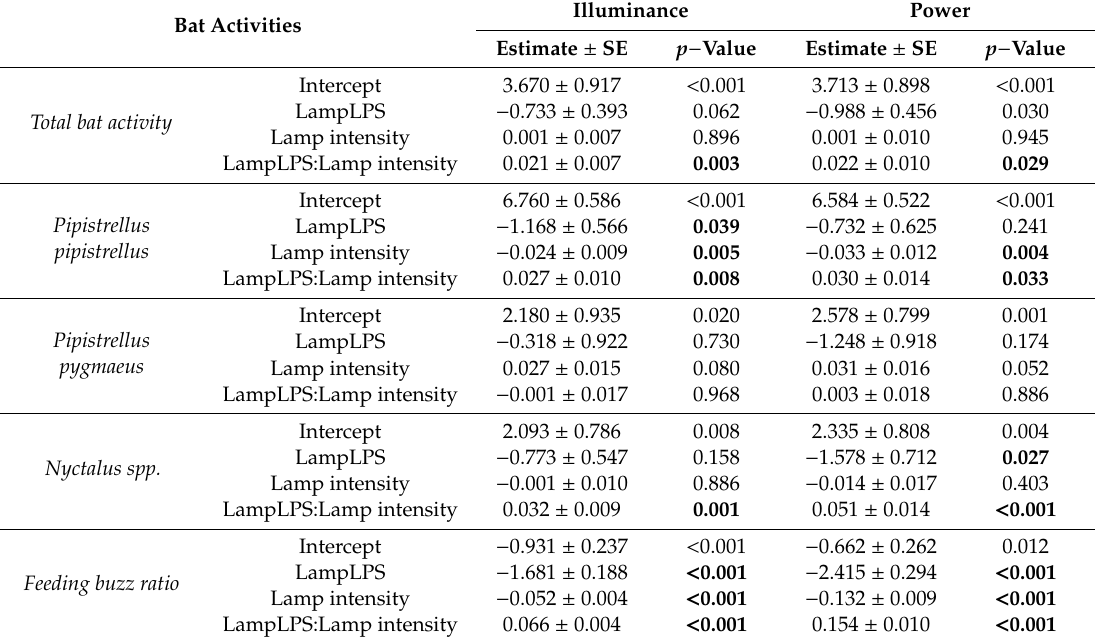
Table 2. E ff ects of the type of lamp (LPS versus LED), the lamp intensity (illuminance or power), and their interaction on bat activity. The estimates of LampLPS are the di ff erence in bat activity between LPS lights and LED lights placed as intercept (i.e., a negative estimate indicates that bat activity is lower with LPS compared to LED for a given light intensity). The estimates of the interaction ( LampLPS:Lamp intensity ) correspond to the di ff erence of slope between the two regressions (bat activity ~ Lamp intensity) according to the lamp type (i.e., LPS versus